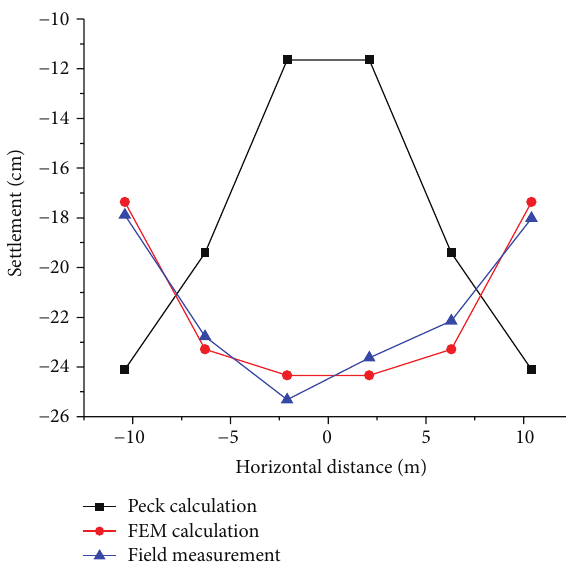
Figure 9: Curves comparison of ground